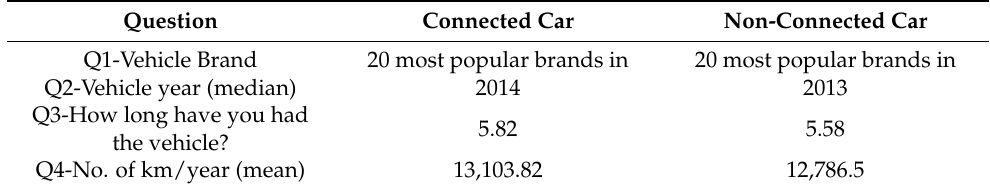
Table 5. Comparison of data of connected and non-connected cars (Section